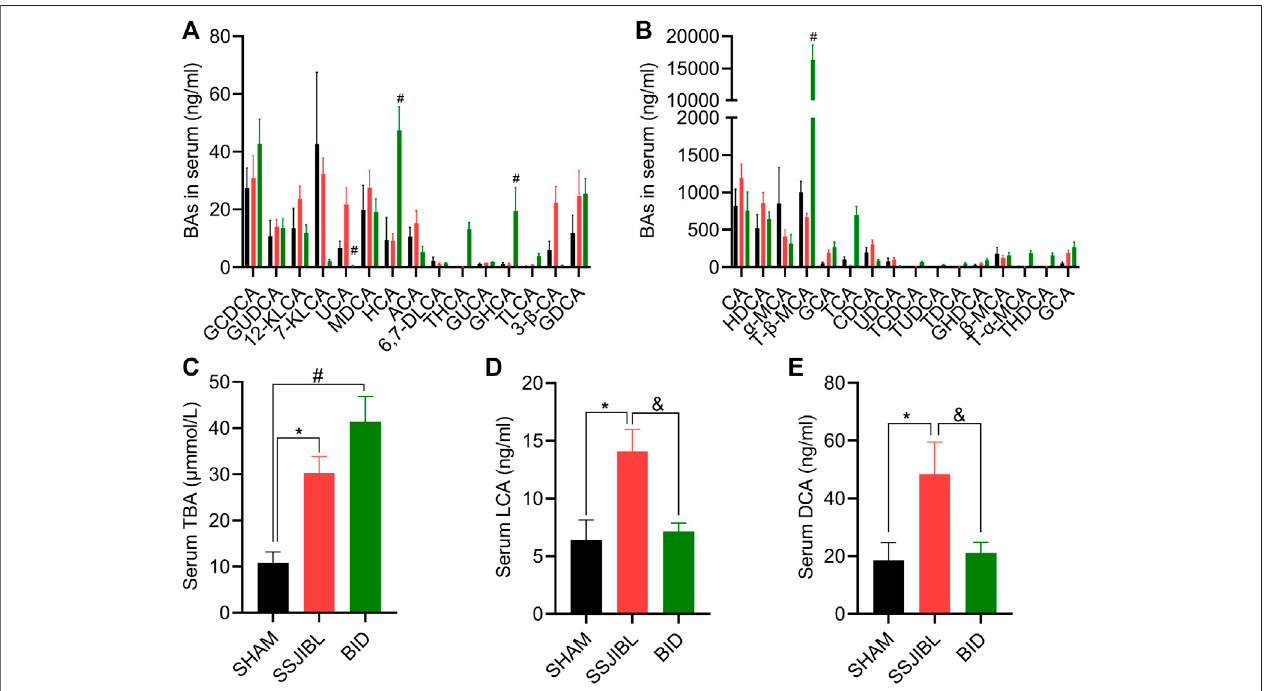
FIGURE 5 | Serum BA composition. (A,B) Absolute values of each BA component in serum at days 14 after surgery. (C) Total serum total bile acids (TBA). (D,E) AbsolutevaluesofLCAandDCA.LCA,lithocholicacid;GLCA,glycolithocholicacid;TLCA,taurolithocholicacid;TDCA,taurodeoxycholicacid;KLCA,12-ketolithocholic acid;6,7-DLCA,6,7-diketolithocholicacid;GUCA,glycoursocholanicacid;3 β -UDCA,3beta-ursodeoxycholicacid;7-KLCA,7-ketolithocholicacid;3 β -CA,3beta-cholic acid; USCA, ursocholic acid; ACA, allocholic acid; nor-DCA, nor-desoxycholic acid; CDCA, chenodeoxycholic acid; DCA, deoxycholic acid; UDCA, ursodeoxy- cholicacid;GDCA,glycodeoxycholicacid;GCDCA,glycochenodeoxycholicacid;TUDCA, tauroursodeoxycholic acid;TCDCA,taurochenodesoxycholicacid;GHDCA, glycohyodeoxycholic acid; β -MCA, beta-muricholic acid; GHCA, glycohy-ocholic acid; MDCA, murideoxycholic acid; HCA, hyocholic acid; CA, cholic acid; GUDCA, glycoursodeoxycholic acid; GCA, glycocholic acid; TCA, taurocholic acid; 23-NCA, 23-norcholic acid; HDCA, hyodeoxycholic acid; α -MCA, alpha-muricholic acid; THCA, taurohyocholic acid; T- α -MCA, tauro-alpha-muricholic acid; THDCA, taurohyodeoxycholic acid; T- β -MCA, tauro-beta-muricholic acid. # p < 0.05 for BID versus SHAM group. * p < 0.05 for SSJIBL versus SHAM group; & p < 0.05 for SSJIBL versus BID group.